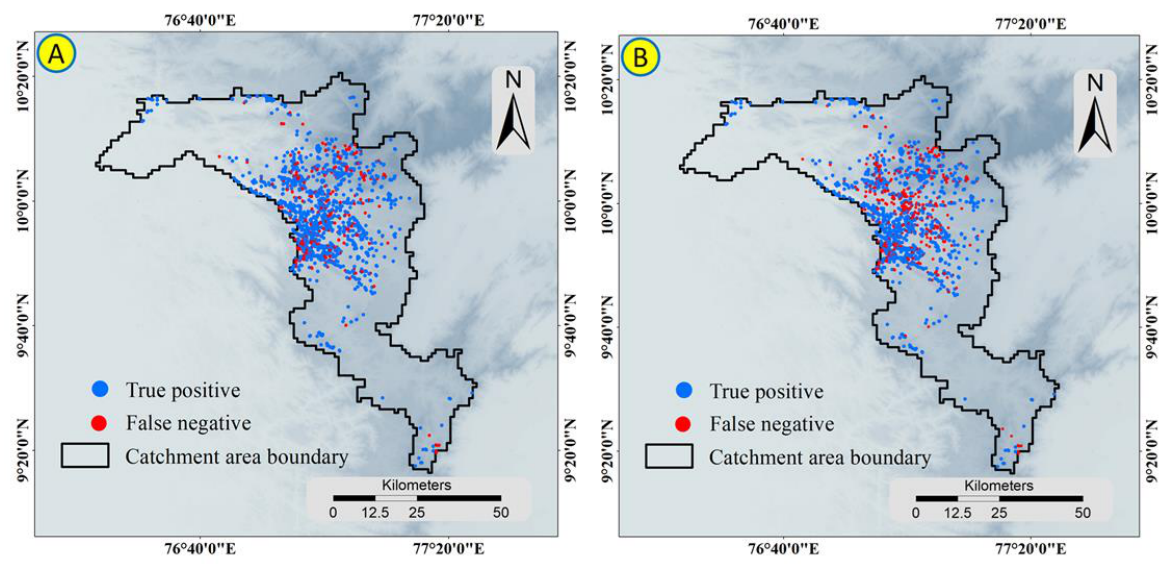
Figure 10. Distribution of false positives and false negatives ( A ) when hydraulic properties were derived from FAO soil texture and ( B ) when hydraulic properties were derived from the soil map of the Soil Survey & Soil Conservation Directorate.